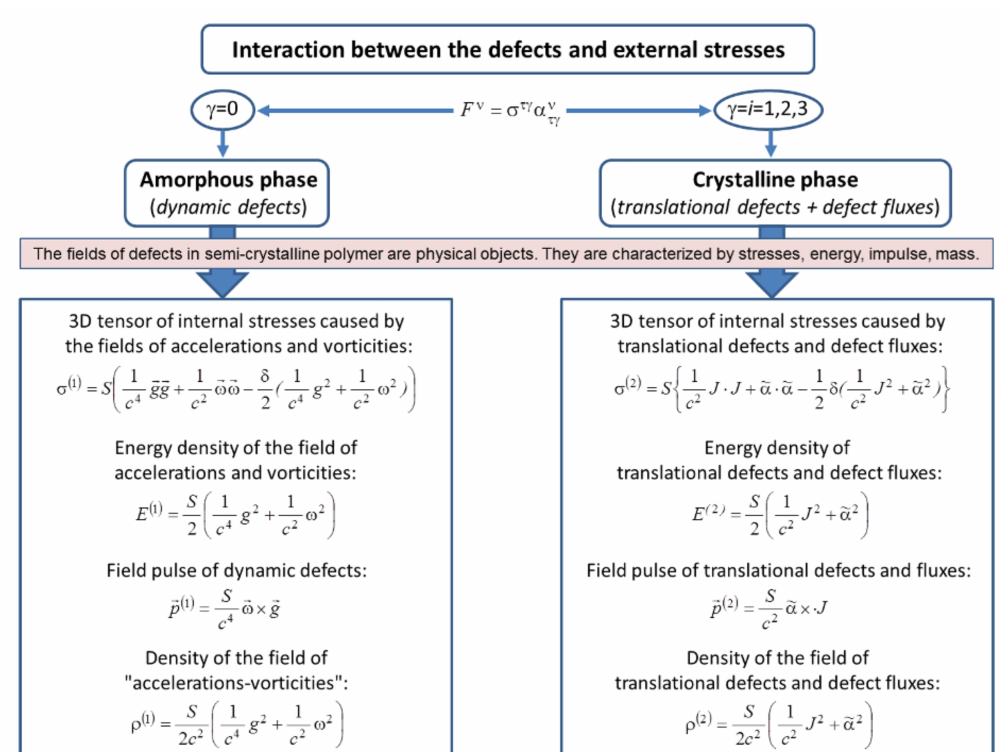
Figure 3. The expressions for the main characteristics of the defects as physical objects, which form the separate subsystem of a semi-crystalline